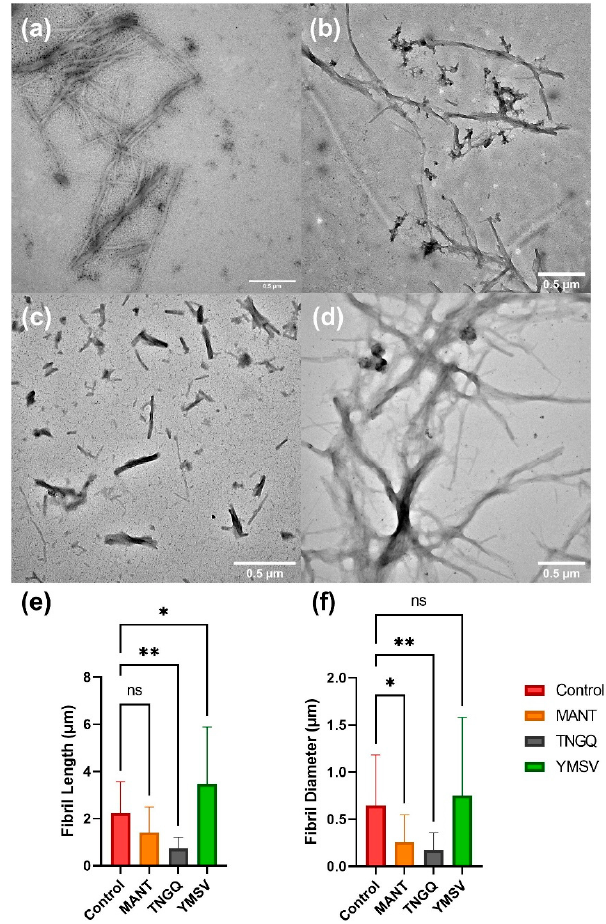
Figure 3. Transmission electron microscopy images of ( a ) IAPP control, and IAPP in the presence of ( b ) MANT, ( c ) TNGQ, and ( d ) YMSV, after 48 h incubation. IAPP fibril ( e ) length and ( f ) diameter quantified using ImageJ software ( n = 24); ns = not significant ( p ≥ 0.05), * = significant (0.01 > p > 0.05), and ** = very significant (0.01 > p > 0.001). Scale bars represent 0.5 μ m.